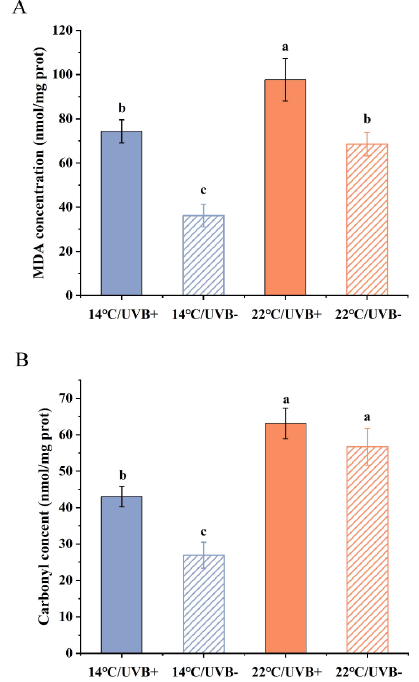
Figure 3. Effect of UVBR (solid bars) and UVBR – free (patterned bars) environments in combination with a 14 (blue bars) or 22 °C (red bars) temperature on the MDA concentration ( A ) and protein carbonyl concentration ( B ) in whole-body Rana kukunoris tadpoles. Data are presented as means ± standard error. Lowercase letters above bars denote significant differences between treatments. The protein carbonyl concentration in the 22 °C groups was higher than that in the 14 °C groups (Figure 3B) (UVBR group: F 3,20 = 13.436, p < 0.01, UVBR-free group: F 3,20 = 13.436, p < 0.01). Meanwhile, the protein carbonyl concentration in the 14 °C/UVBR group was significantly higher than that of the 14 °C/UVBR-free group ( F 3,20 = 13.436, p < 0.05),